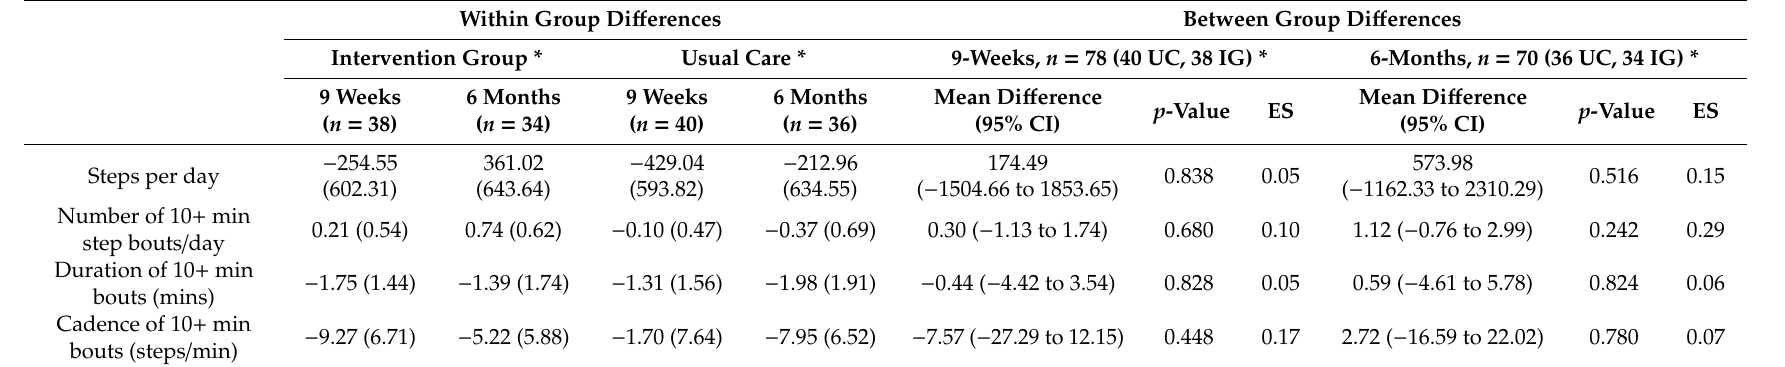
Table 4. Within and between-group PA variable change scores at nine-week and six-month follow-ups. Within Group Di ff